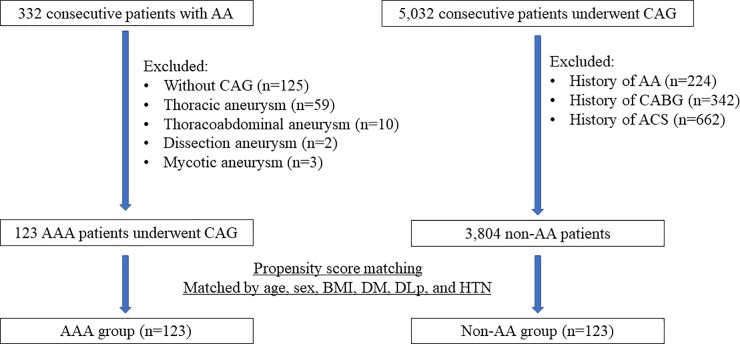
Study flow of this study.Abbreviations: AA, aortic aneurysm; AAA, abdominal aortic aneurysm; ACS, acute coronary syndrome; BMI, body mass index; CABG, coronary artery bypass graft; CAG, coronary angiography; DLp, dyslipidemia; DM, diabetes mellitus.